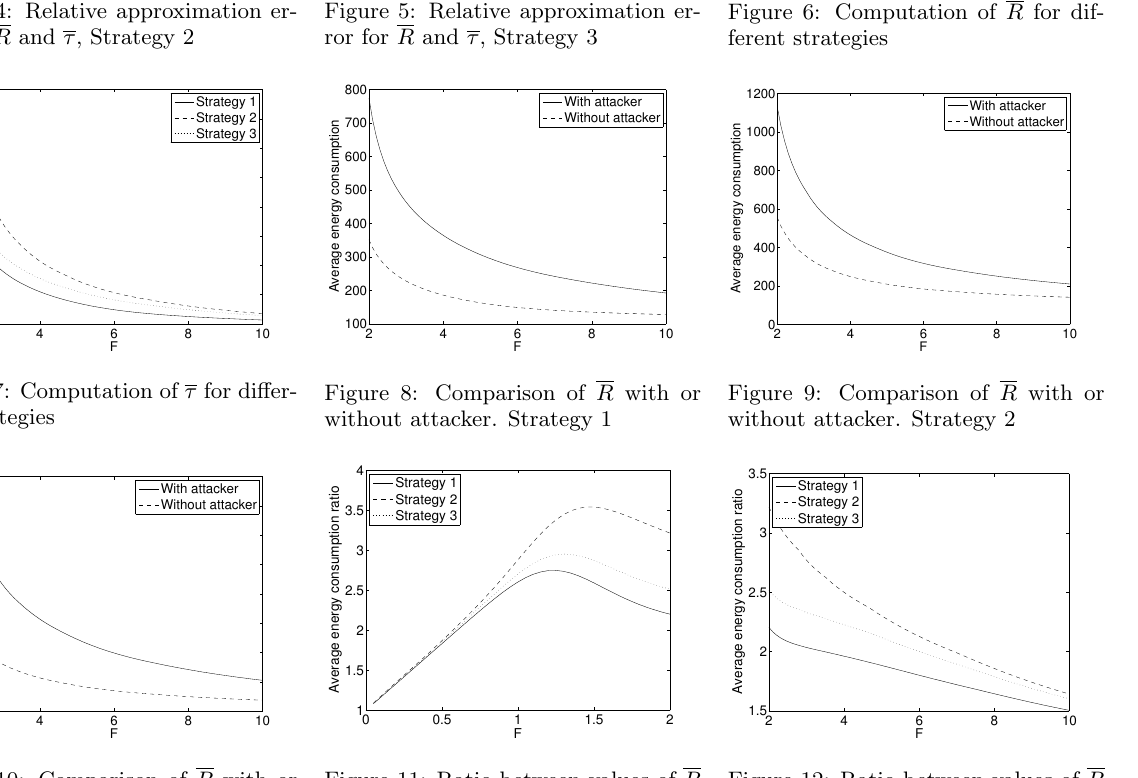
Figure 10: Comparison of R with or without attacker. Strategy 3